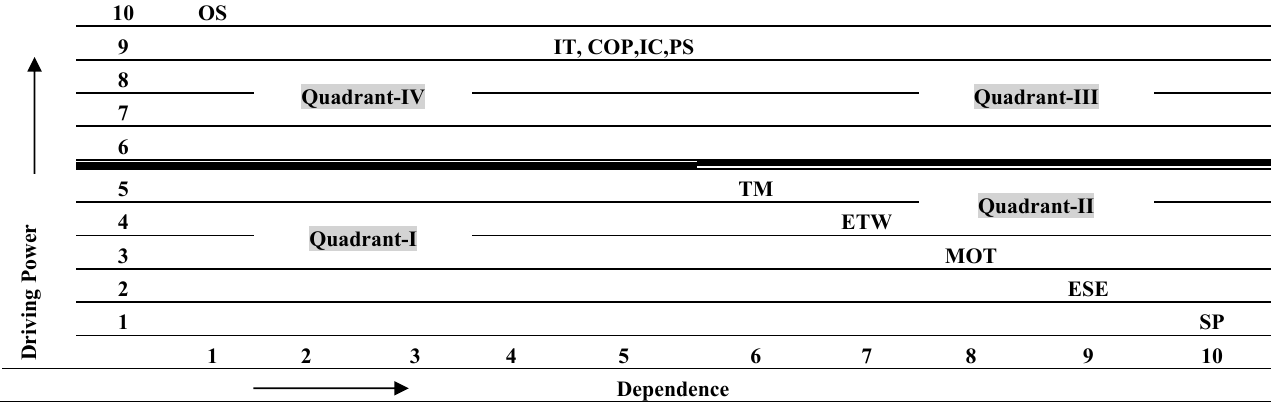
Figure 1. Driving power and dependence power diagraph. (Source: Survey data and author’s calculation). All the variables are displayed in four quadrants,